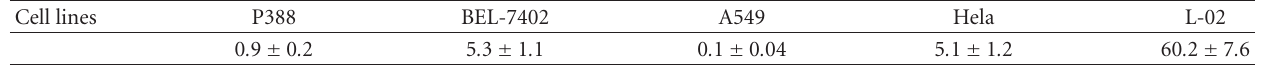
Table 1: IC 50 ( μ M) values obtained after 72 h of continuous Van-7 exposure.